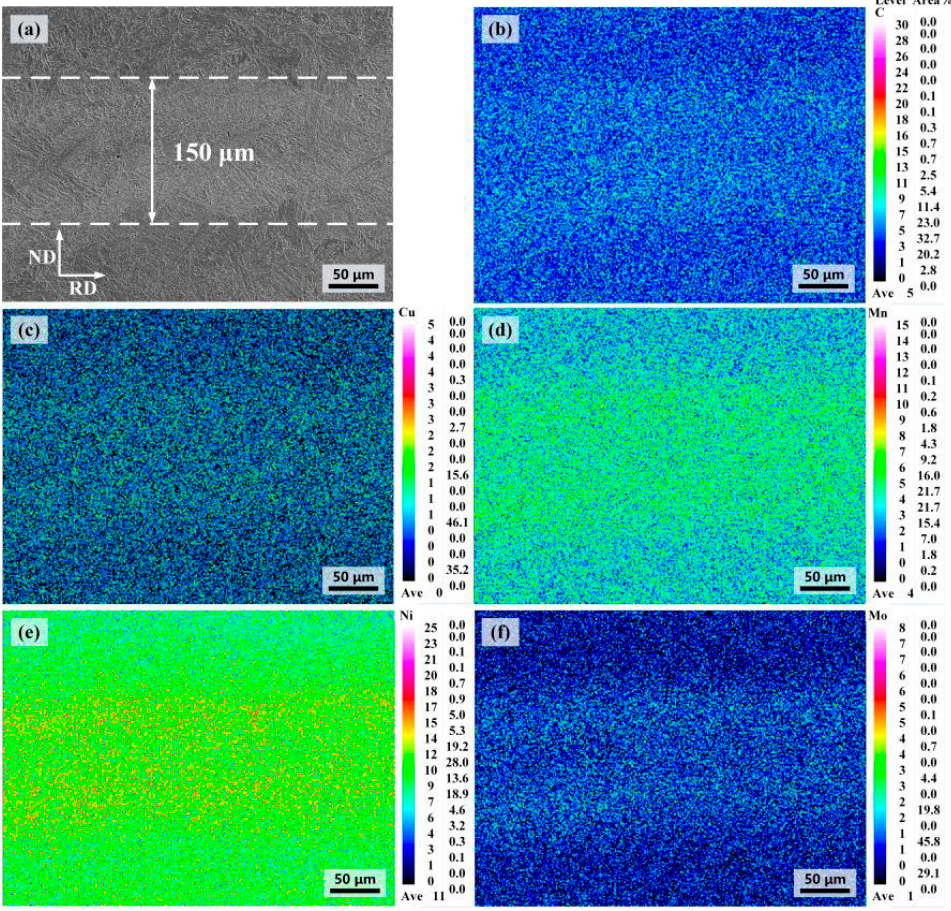
Figure 11. Electron probe microanalysis (EPMA) map scanning results. ( a ) SEM micrograph of the macrosegregation region, ( b – f ) the corresponding distribution of C, Cu, Mn, Ni, Mo, respectively. Table 4. Measured chemical composition of the experimental steel, in wt. %.